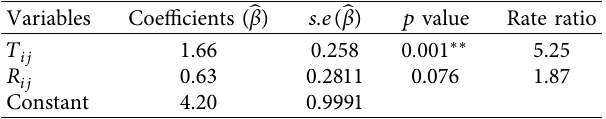
Table 2: Estimation results for the efects of daily average tem- perature and total rainfall on dengue